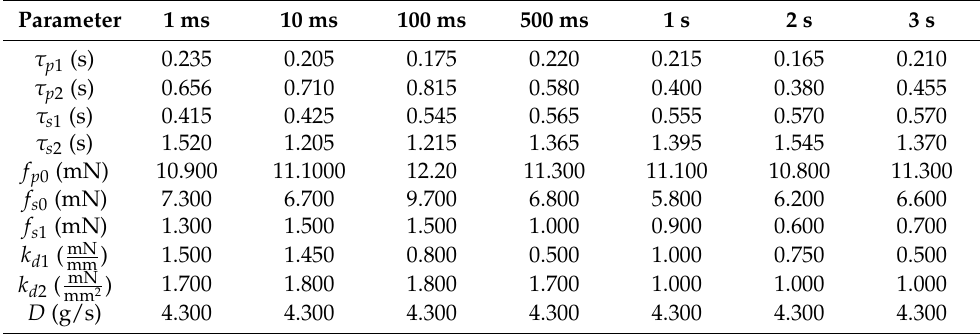
Table 2. Extracting parameters of the measured pupillary light reflex in seven stimulus durations.